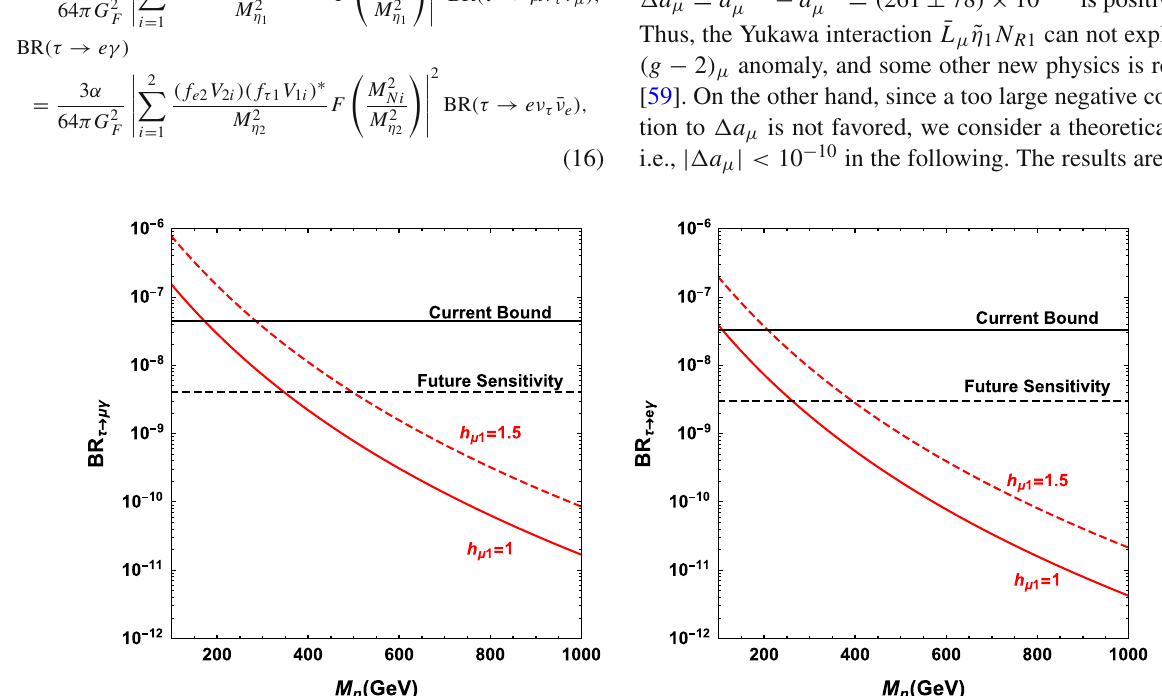
Fig. 3 Predictions for τ → μγ (left) and τ → e γ (right) with corresponding current bound [57] and future sensitivity [58]. In these figures, we = 200 have fixed M N 1